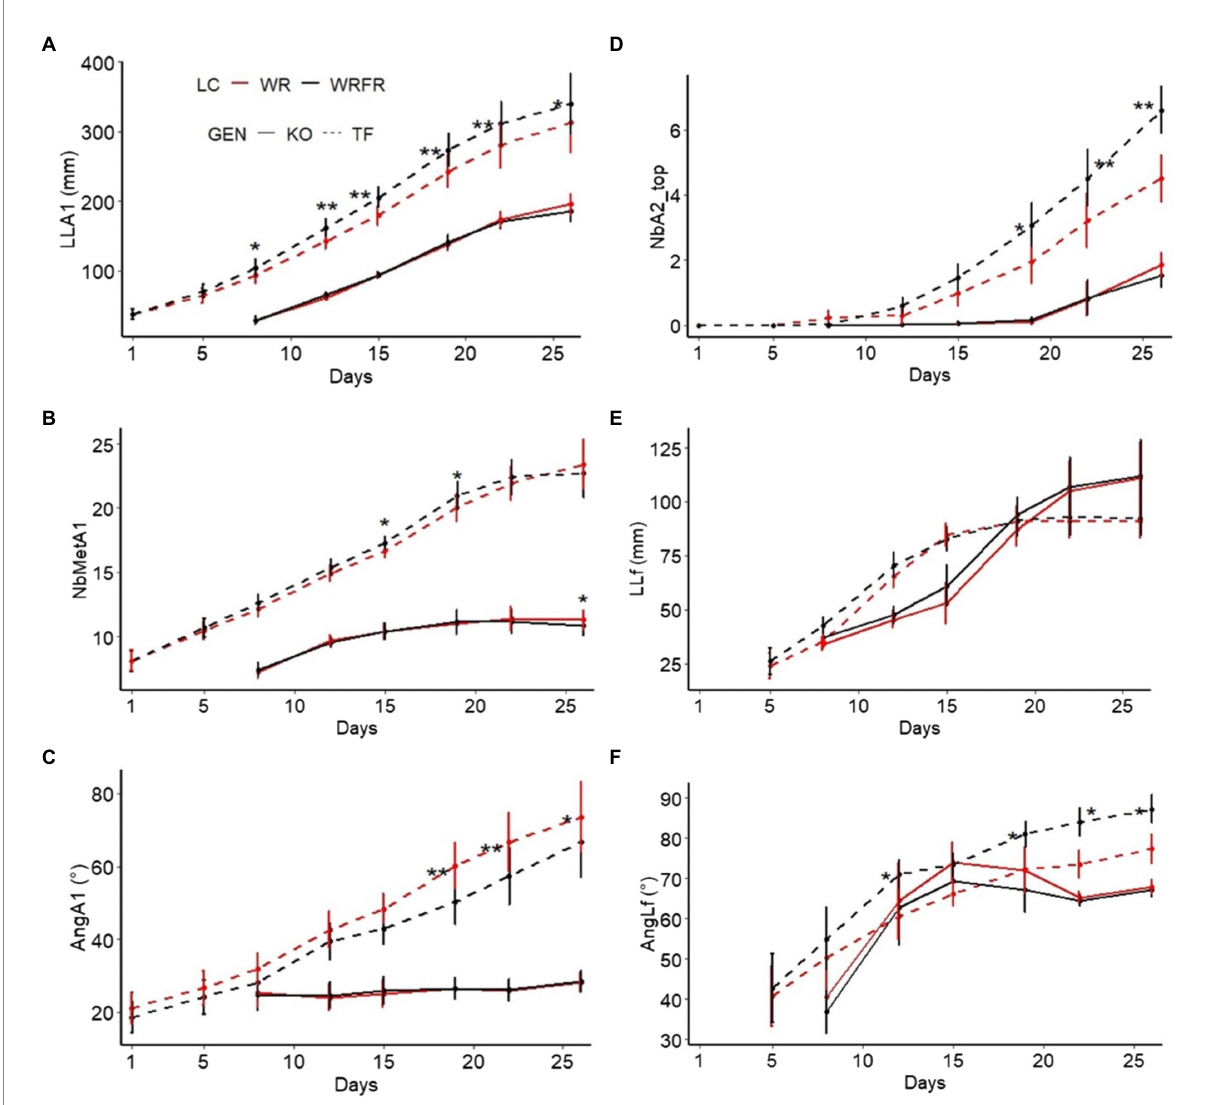
FIGURE 3 Kinetics of the construction of the order 1 long axis for Knock Out ® Radrazz (KO) and ‘The Fairy’ (TF) grown in a climate chamber under two light conditions: WR and WRFR. Kinetics of the elongation of the order 1 long axis (LLA1, length of the order 1 long axis; A ). Kinetics of metamer emission by the order long 1 axis (NbMetA1, number of metamers of the order 1 long axis; B ). Kinetics of the inclination angle of the order 1 long axis (AngA1, angle of inclination of the cord (relative to the vertical) of the order 1 long axis; C ). Kinetics of top branch emission by the order 1 long axis (NbA2_top, number of order 2 axes carried by the order 1 long axis in apical position; D ). Kinetics of the elongation of the 7th leaf (LLf, length of the 7th leaf carried by the order 1 long axis; E ). Kinetics of the inclination angle of the 7th leaf (AngLf, angle of inclination of the cord (relative to the vertical) of the 7th leaf carried by the order 1 long axis; F ). Error bars represent SEMs ( n = 16). For each genotype (GEN), asterisks indicate statistically significant differences between the light conditions (LC; Tukey’s test, ** p < 0.001; * p <